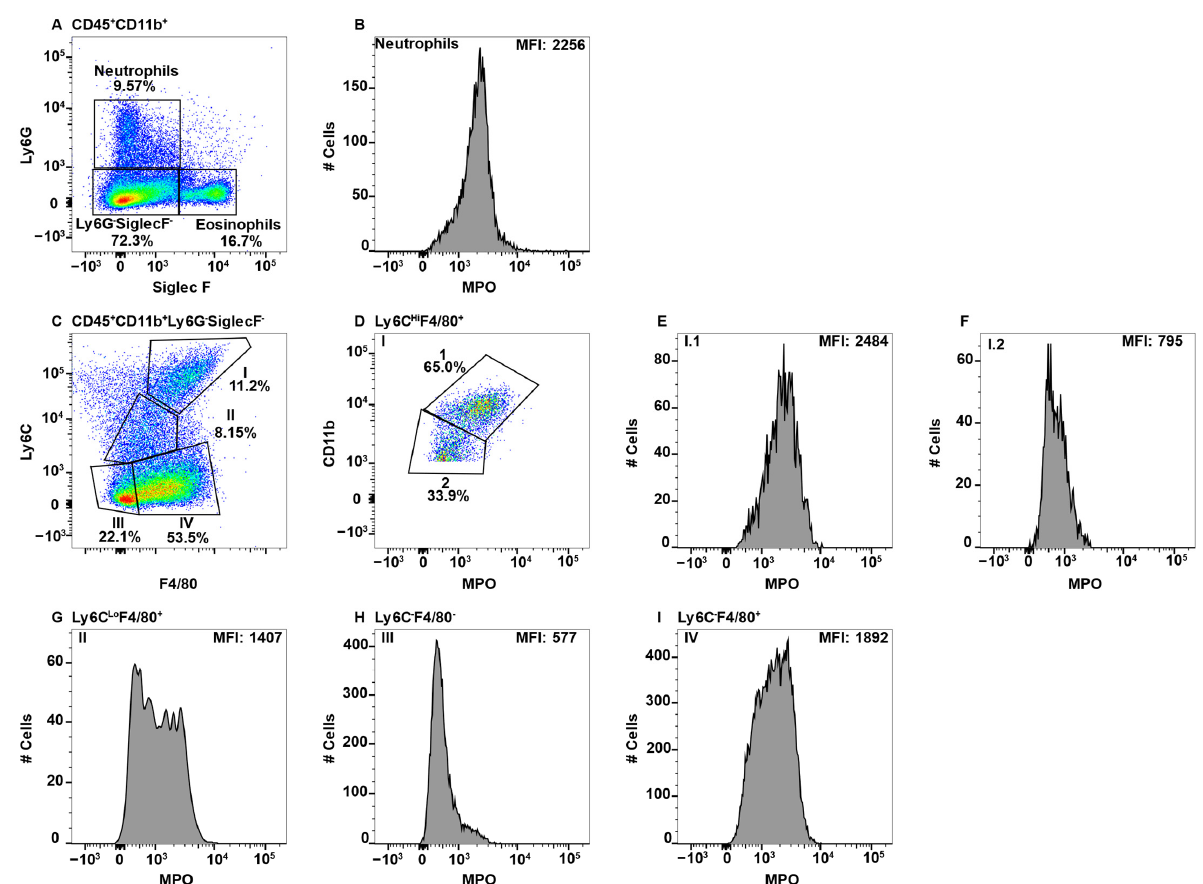
Figure 5. Large intestinal macrophage subsets differentially express MPO. Large intestine mononu- clear cells were stained with antibodies specific for CD45, CD11b, Ly6C, Ly6G, F4/80, MPO, and SiglecF and using flow cytometry, CD45 + CD11b + cells were analyzed for Ly6G and SiglecF expression to identify Ly6G + SiglecF − neutrophils and Ly6G − SiglecF + eosinophils ( A ). Neutrophil MPO-positive staining is shown ( B ). CD45 + CD11b + Ly6G − SiglecF − cells analyzed for F4/80 and Ly6C identified four Subpop (I–IV) ( C ). Subpop I F4/80 + Ly6C Hi cells were separated into CD11b Hi (1) and CD11b Lo (2) populations ( D ), and MPO expression is shown ( E and F , respectively). MPO expression in Subpop II Ly6C Lo F4/80 + ( G ), III Ly6C − F4/80 − ( H ) and IV Ly6C − F4/80 + ( I ) is shown. The percent positive